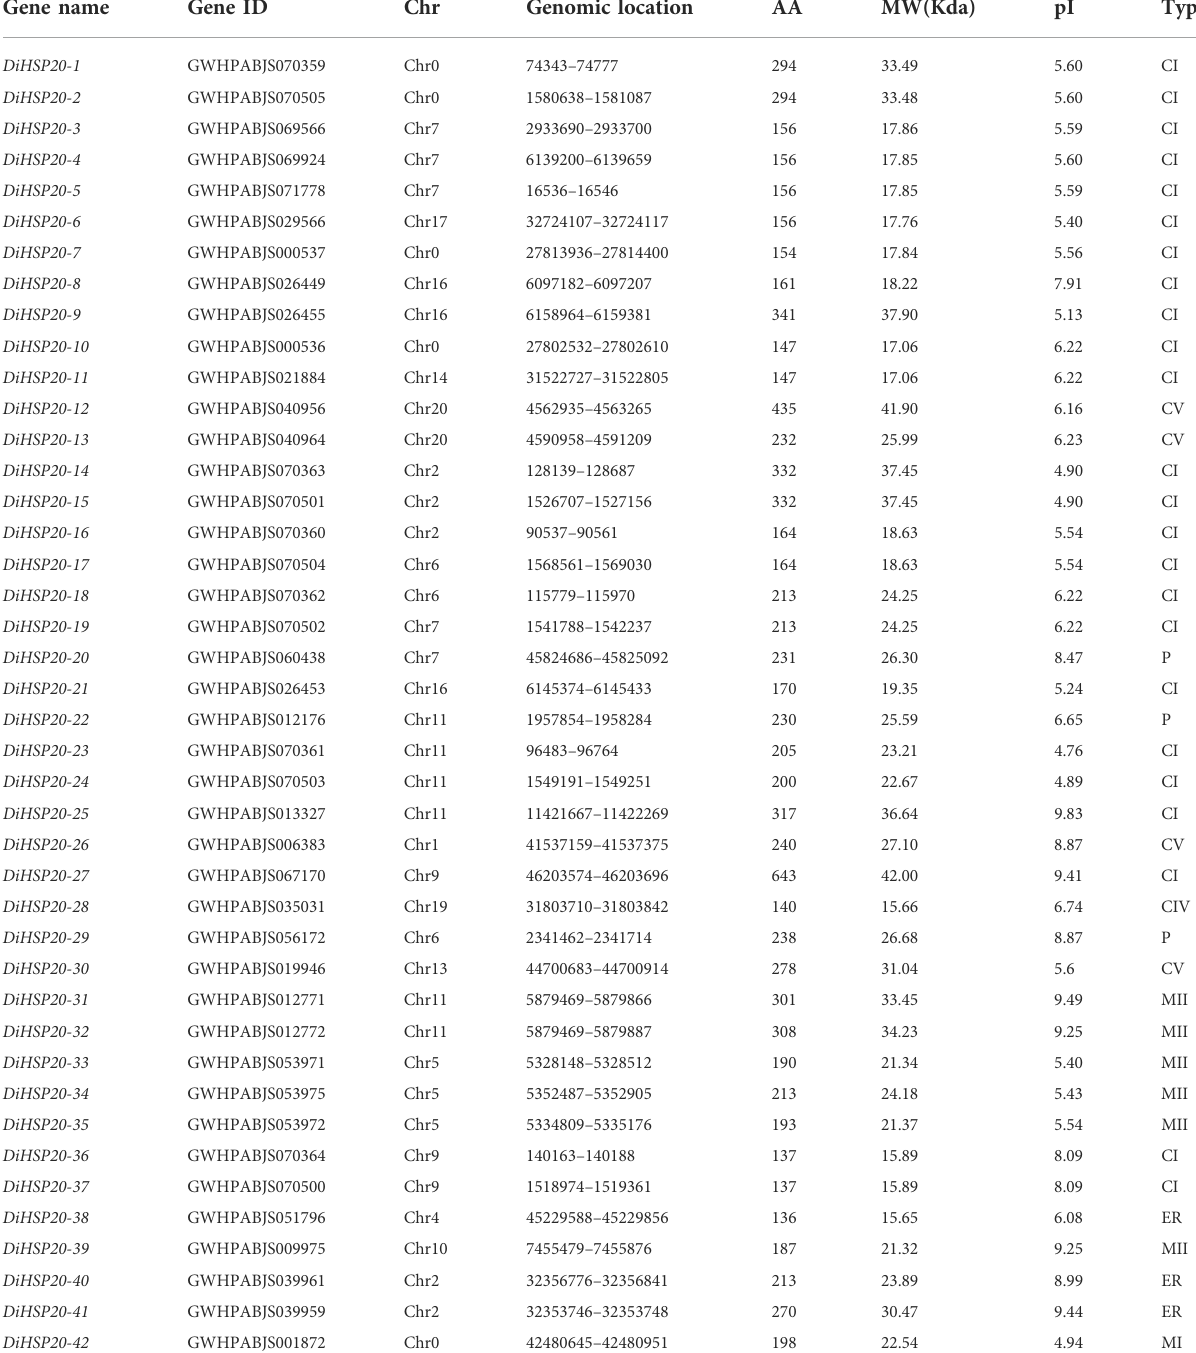
TABLE 1 Features of DiHSP20 genes in D. involucrata